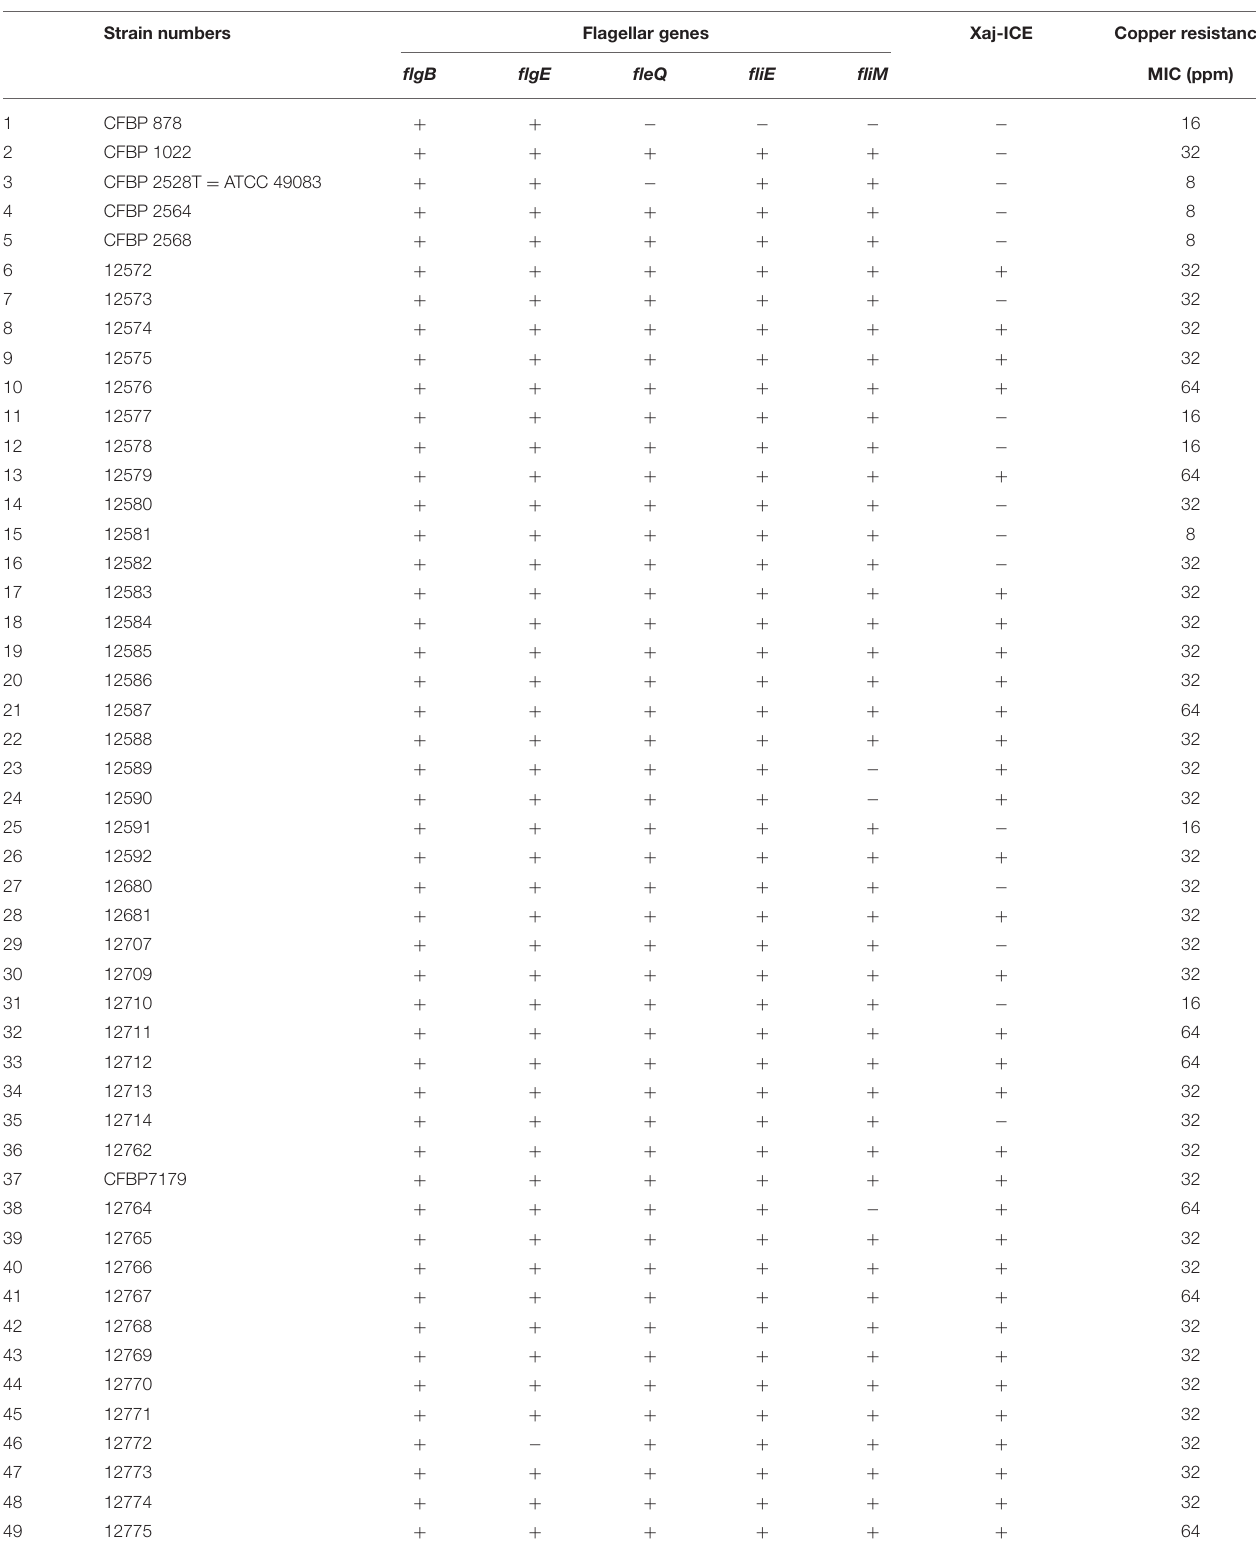
TABLE 2 | Copper resistance and PCR results on flagellar genes and on